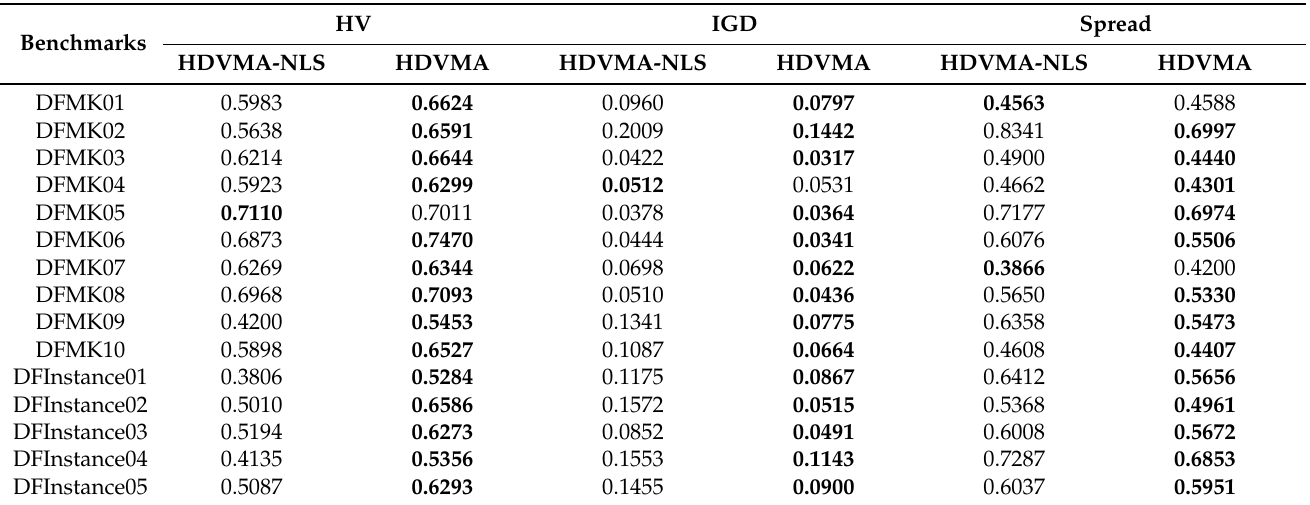
Table 6. Comparison of DVNS